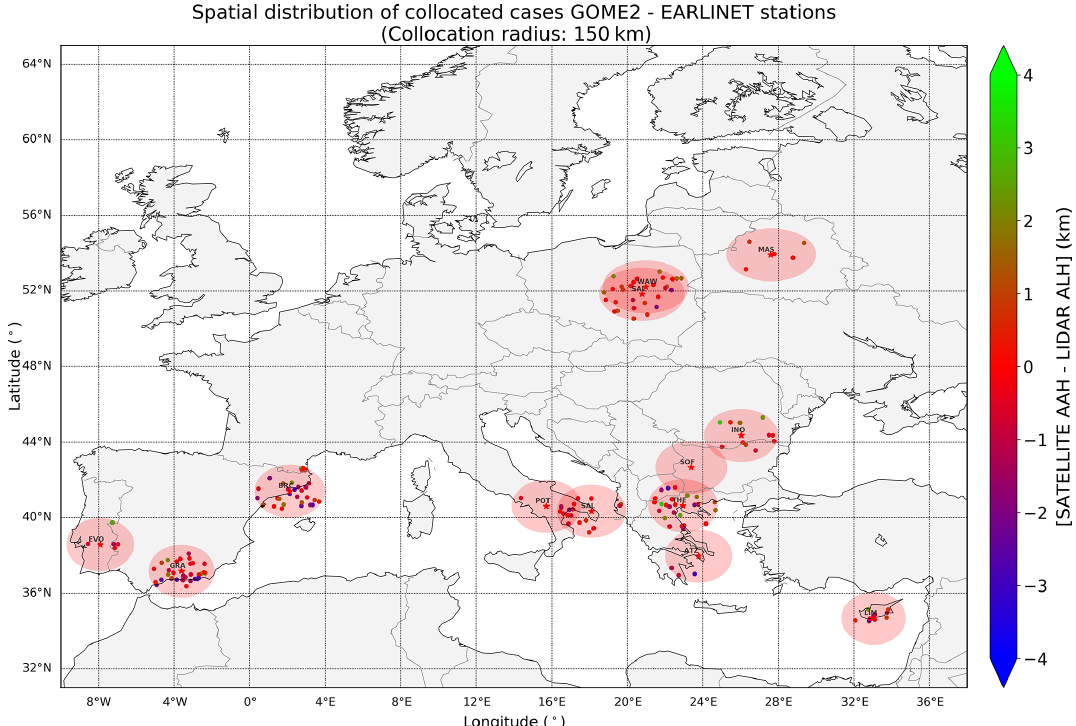
Figure 5. Spatial distribution of collocated pairs between GOME-2/MetOp and EARLINET stations for the sites including in the validation study. The colour codes denote the absolute difference between GOME-2/MetOp AAH and the retrieved aerosol height from EARLINET data for each collocated pair. The concentric red circles denote regions of 150km from the location of EARLINET stations. Refer to Table 2 for the EARLINET code names shown in the legend.